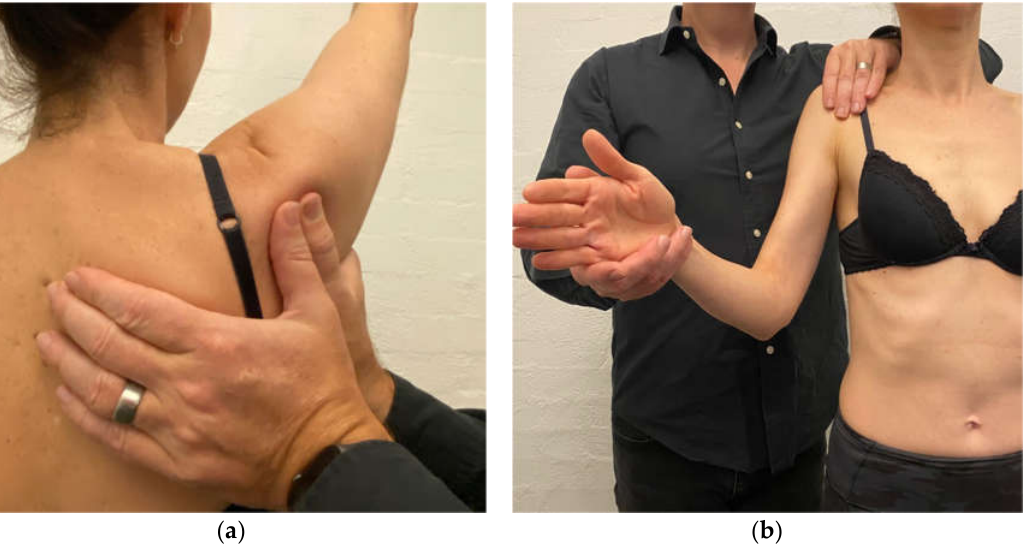
Figure 2. ( a ) Posterior humeral head correction during active shoulder flexion; ( b ) anterior humeral head correction during isometric load of external rotation.